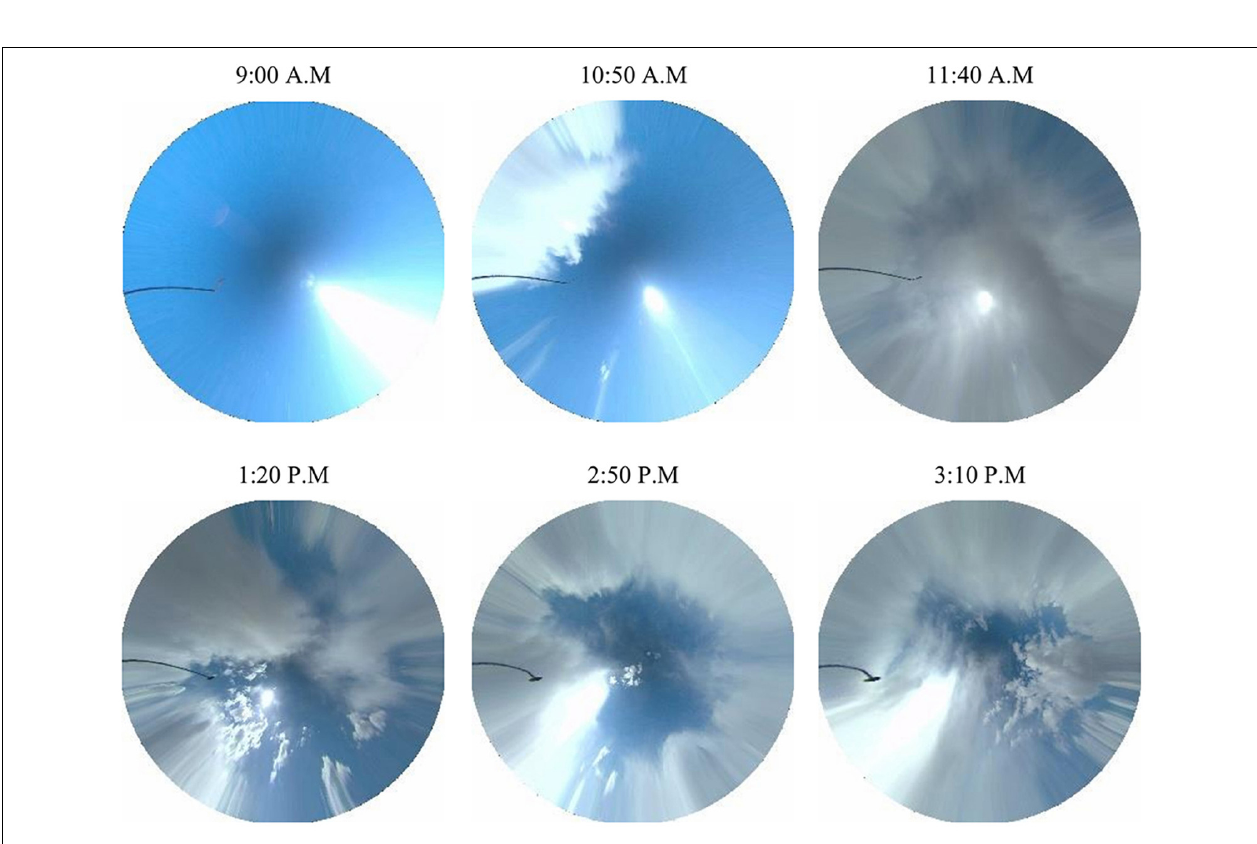
FIGURE 7 | Regression plots of the ANN training process for (Up-left) the training dataset, (up-right) test dataset, (down-left) validation dataset, and (down-right) whole dataset.